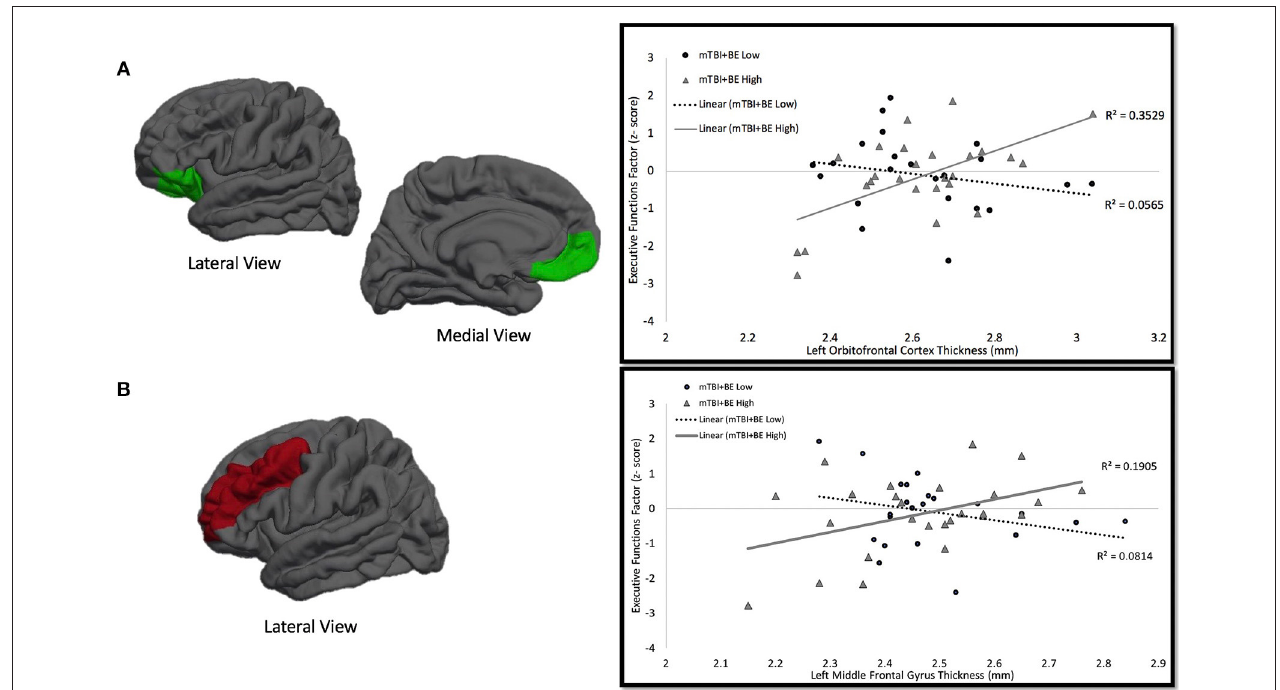
FIGURE 2 | mTBI + BE Low vs. High × Cortical Thickness on Executive Functions Factor Interaction. (A) One the left side is a depicition of the left oribitofrontal cortex. On the right is the association between thickness of left orbitofrontal cortex and performance on an executive functions factor. The circles and dotted line represent the mTBI + BE Low group, whereas the triangles and solid line represent the mTBI + BE High group. (B) One the left side is a depicition of the left middle frontal gyrus. On the right is the association between thickness of left middle frontal gyrus and performance on an executive functions factor. The circles and dotted line represent the mTBI + BE Low group, whereas the triangles and solid line represent the mTBI + BE High